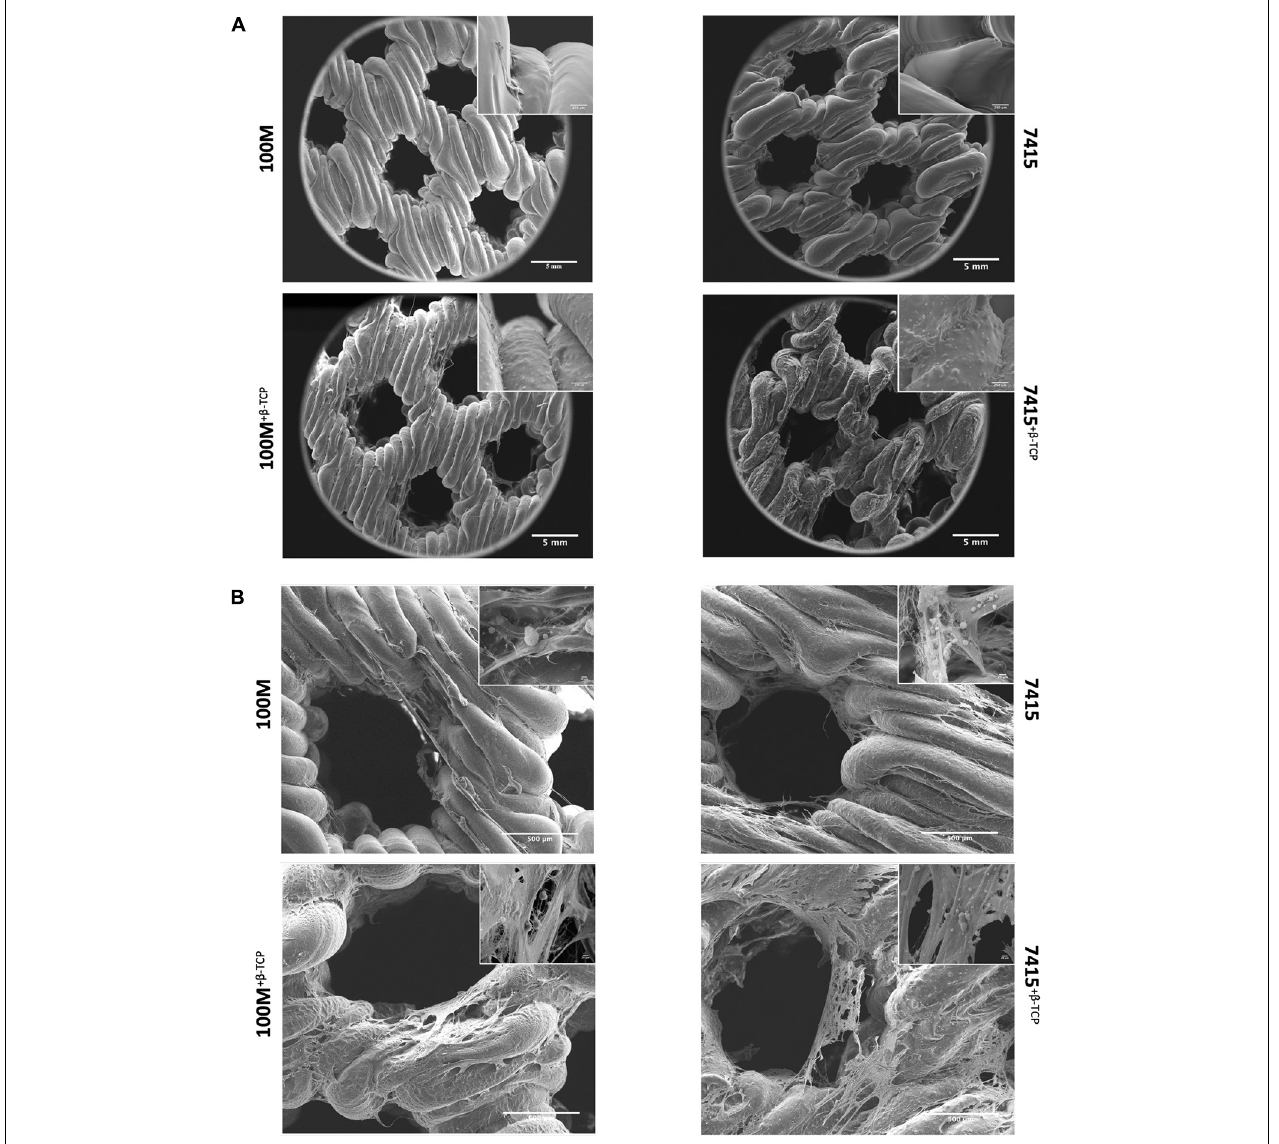
FIGURE 2 | Surface morphology of scaffolds with and without cells. (A) Scanning electron microscopy of empty scaffolds. Representative SEM images at 80 × and 1500 × magnifications and scale bars represents 5 mm, 250 µ m ( n = 3). (B) Cell-seeded scaffolds were clearly covered with matrix deposition after 21 days of culture at 200 × and 6000 × x magnifications and scale bars represents 500, 20 µ m ( n =